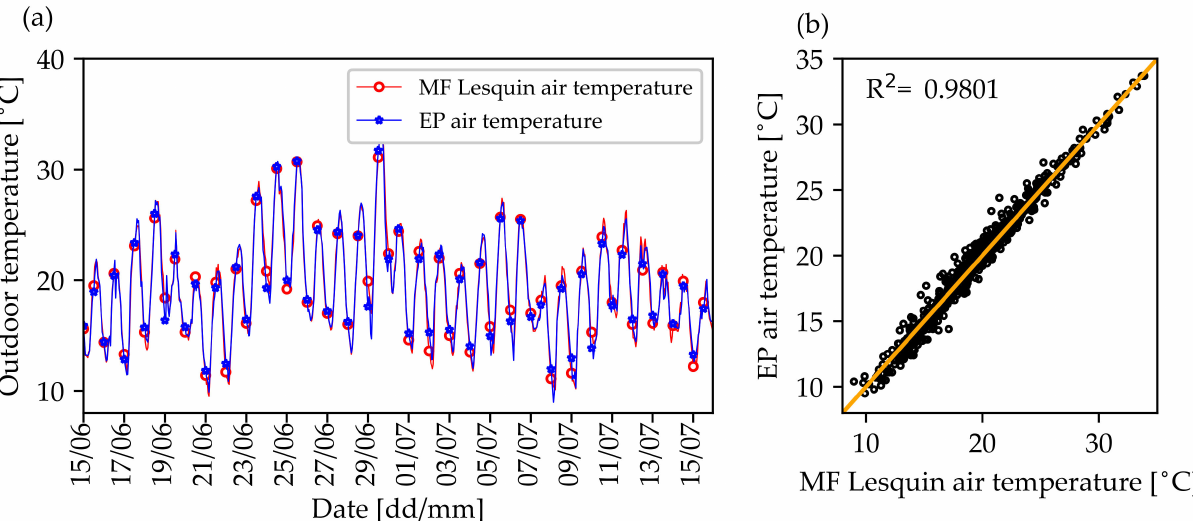
Figure 7. ( a ) Hourly variation of outdoor temperature (red continuous lines with round markers— ◦ C) measured by the M é t é o France (MF) weather station of Lesquin and hourly variation of the Experimental Platform (EP) outdoor temperature (blue continuous lines with star markers) between 15 June 2019 and 15 July 2019. ( b ) Comparison between the air temperatures of the EP and the MF weather station located in